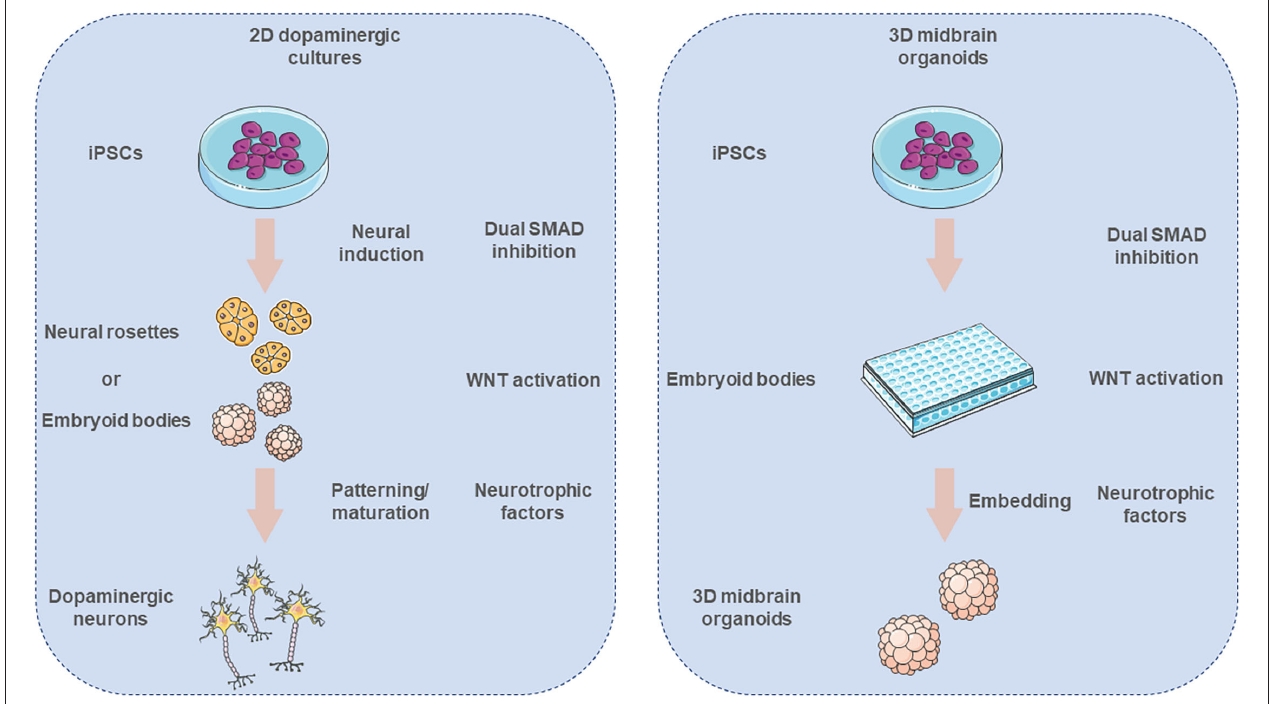
FIGURE 2 | Derivation of in vitro iPSC-derived 2D dopaminergic neuronal cell cultures and 3D midbrain organoids. Neural induction of iPSCs is promoted via dual SMAD inhibition. Pluripotent cells form neural rosettes or embryoid bodies (EBs), that subsequently are patterned toward ventral midbrain identity. After the initial patterning the neurons are further cultured with chemically defined media in order to give rise to mature midbrain neuronal cultures. In the case of the midbrain organoid cultures, first the iPSCs are forming EBs and then get embedded into an extracellular matrix that supports the 3D growth of these organoids. The illustration was created using images from